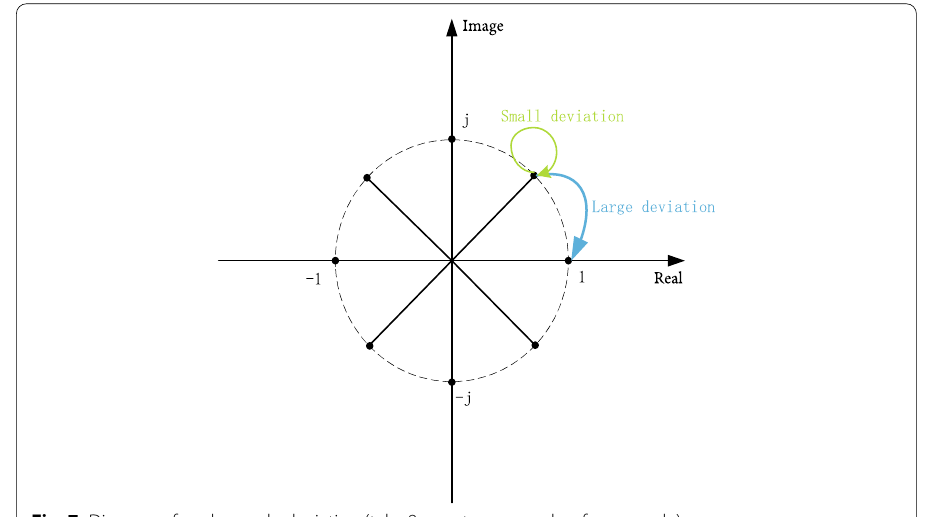
Fig. 7 Diagram of analog code deviation (take 8 as antenna number for